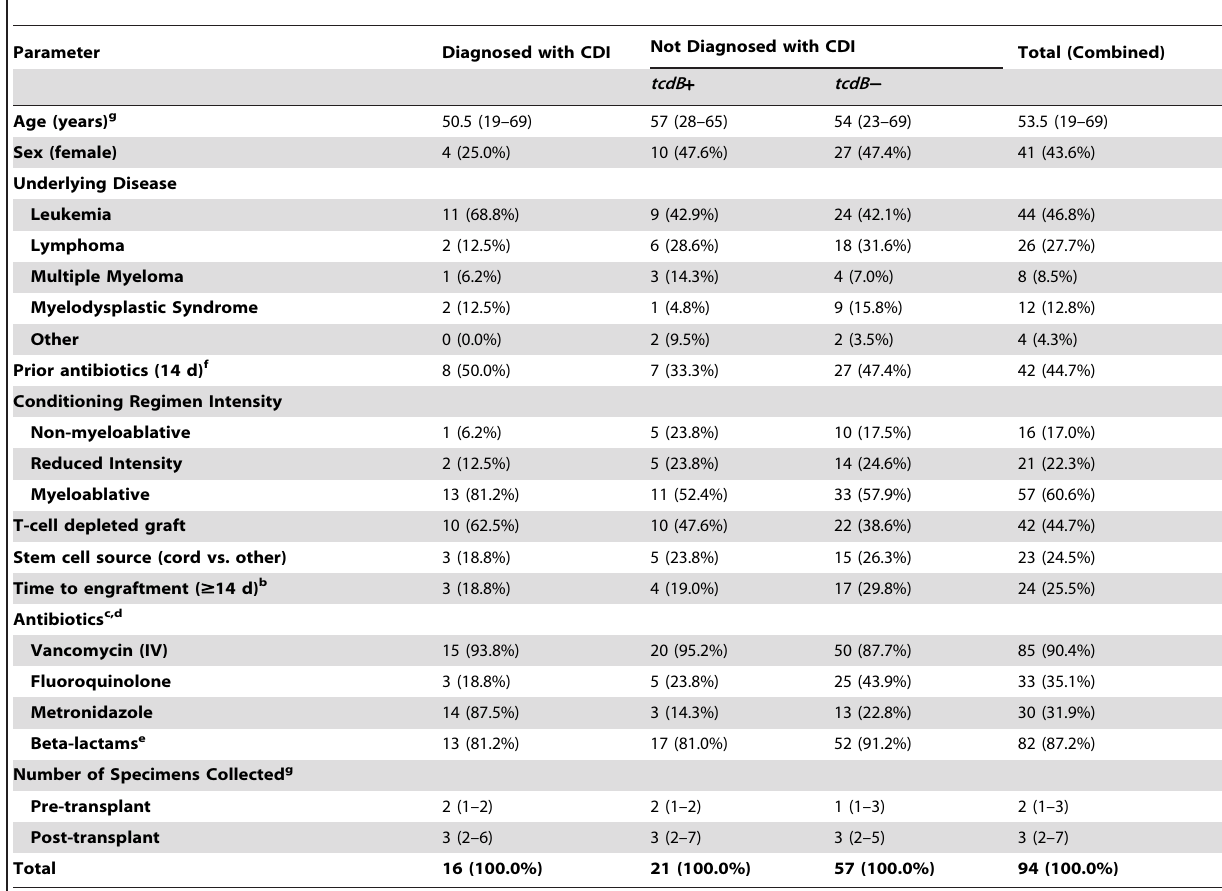
Table 1. Characteristics of Patients, Biospecimen Group (N= 94) a